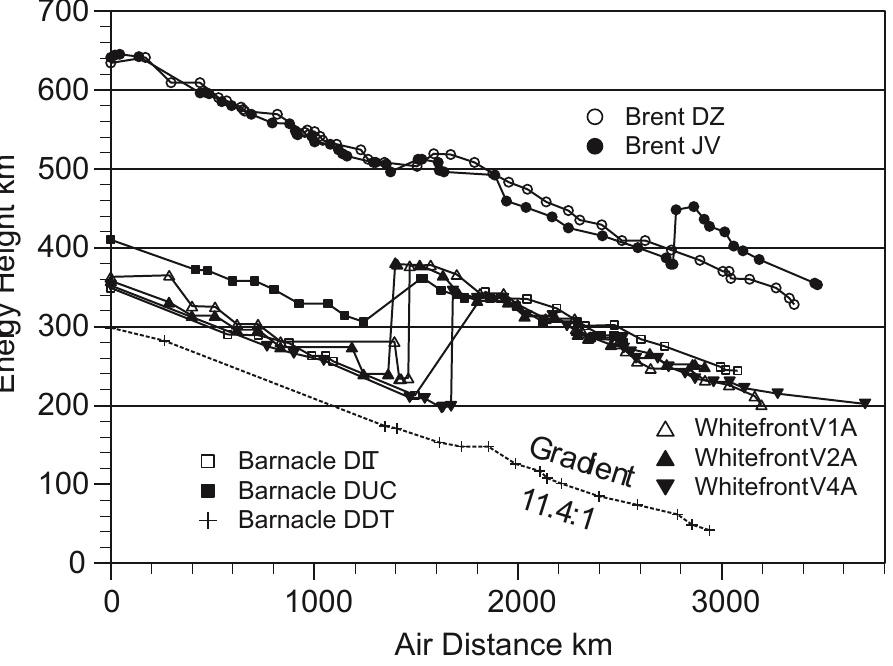
Figure 6. The energy heights achieved by different goose species are about 15:1, taking account of stops, as compared to a calculated maximum of about 19:1. Energy height is built up during feeding stopovers, and no goose wants to arrive anywhere below 200 km in spring. The Brent Geese, with the longest routes, stayed above 300 km. The fuel is not allowed to run low in spring migrations, but may do so in the autumn